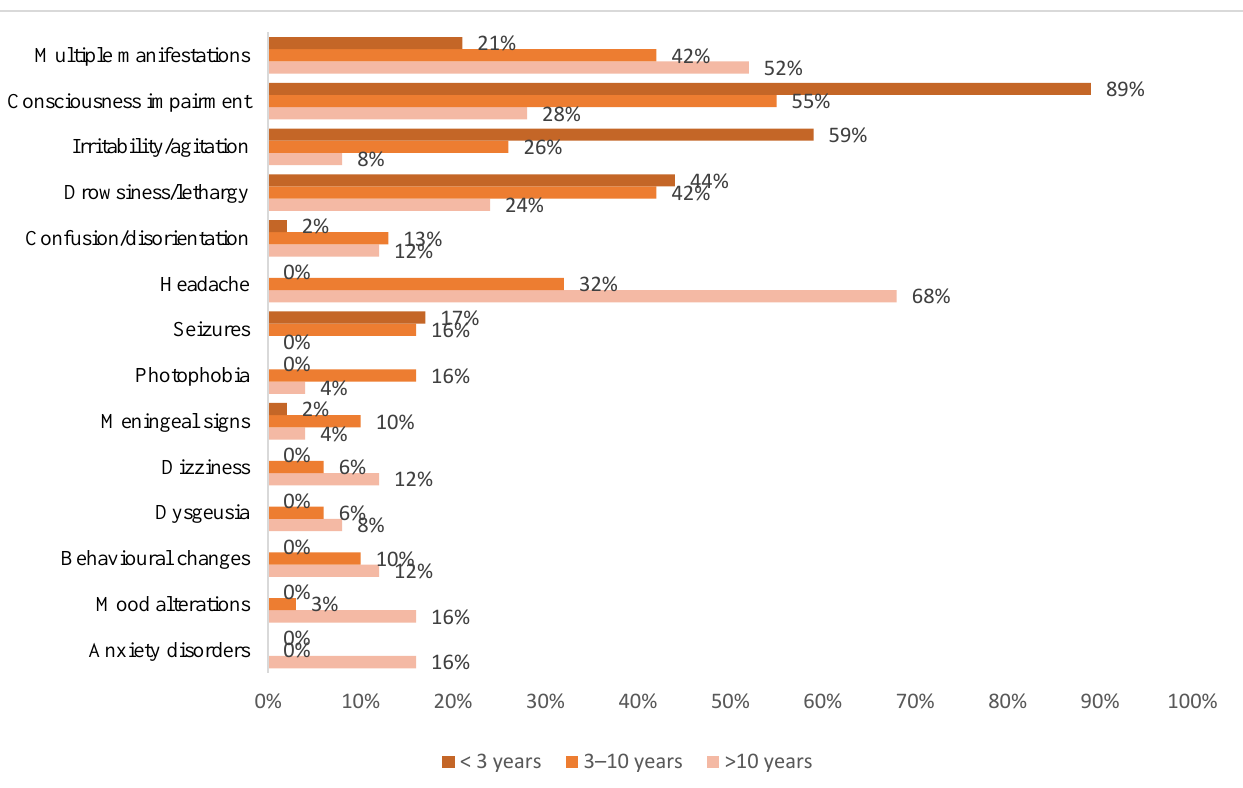
Figure 1. Stratification by age of main neurological manifestations.